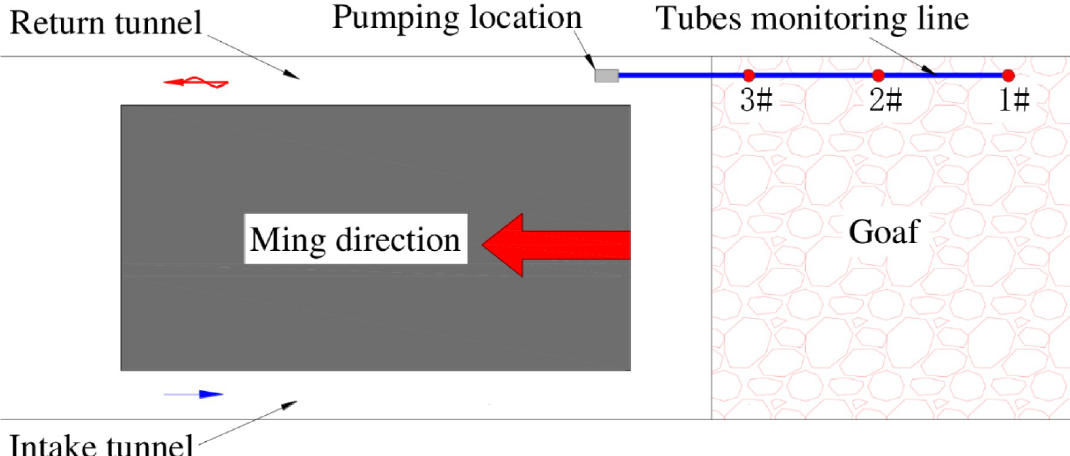
Fig 9. Layout of measuring points of pre-embedded beam tube in working